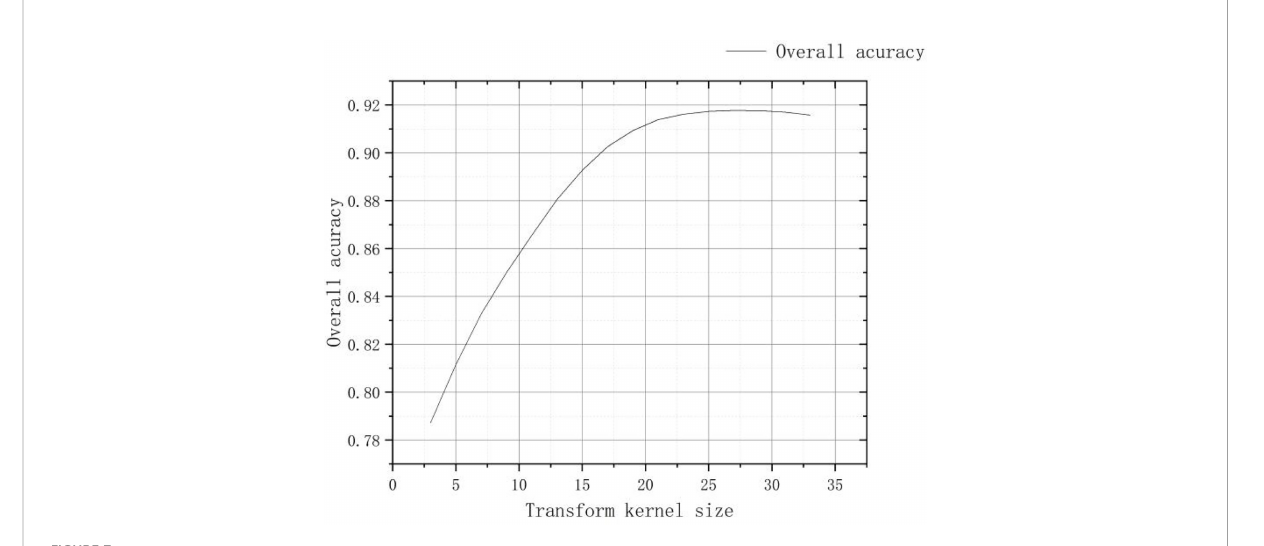
FIGURE 7 Confusion matrix veri fi cation accuracy curve after removing small patches.